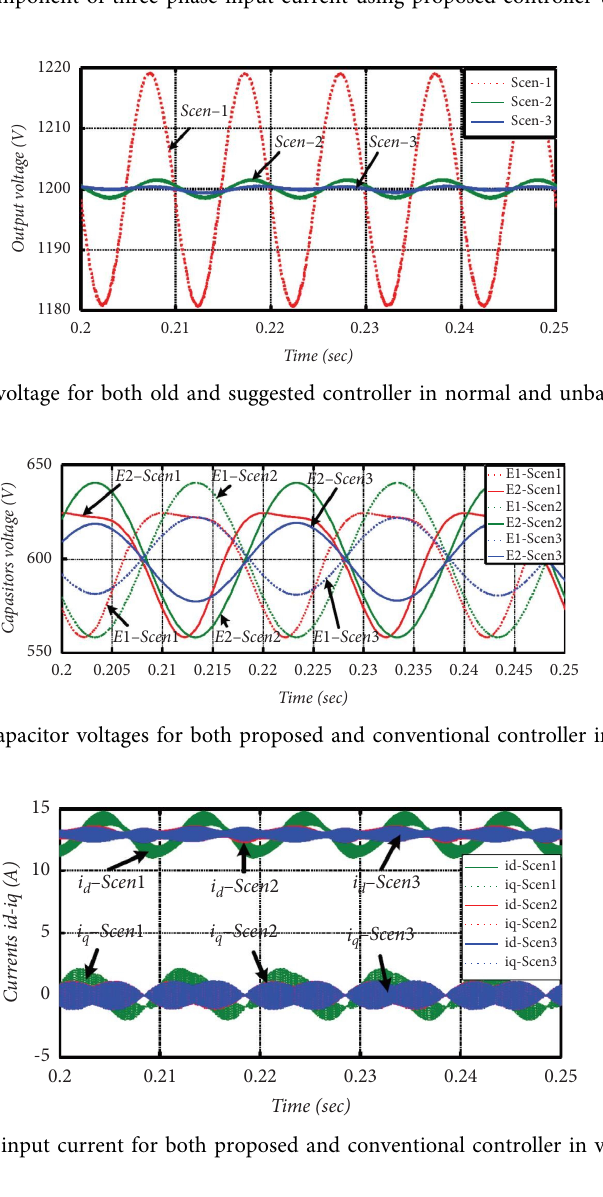
Figure 11: Negative sequence component of three-phase input current using proposed controller under unbalanced grid voltage.